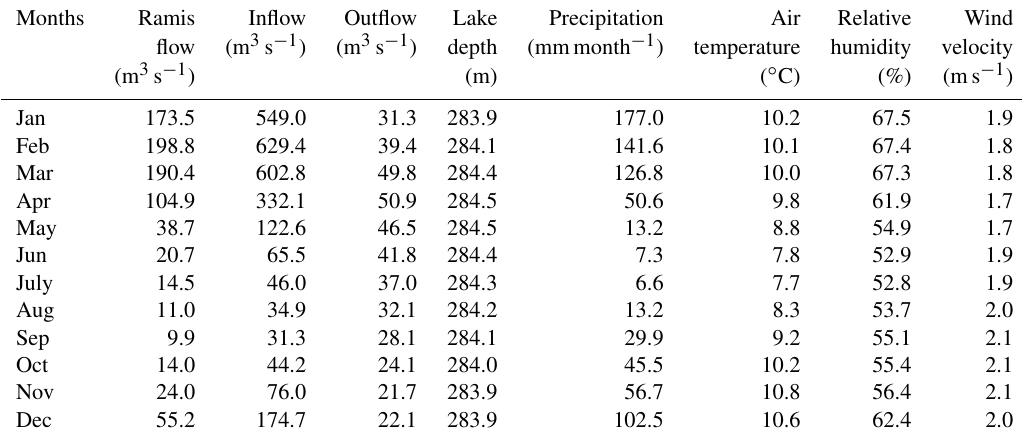
Table 1. Climatological and hydrological components of Lake Titicaca for 1966–2011. Months Ramis Inflow Outflow Lake Precipitation Air Relative Wind flow (m 3 s − 1 ) (m 3 s − 1 ) depth (mmmonth − 1 ) temperature humidity velocity (m 3 s − 1 ) (m) ( ◦ C) (%) (ms − 1 )